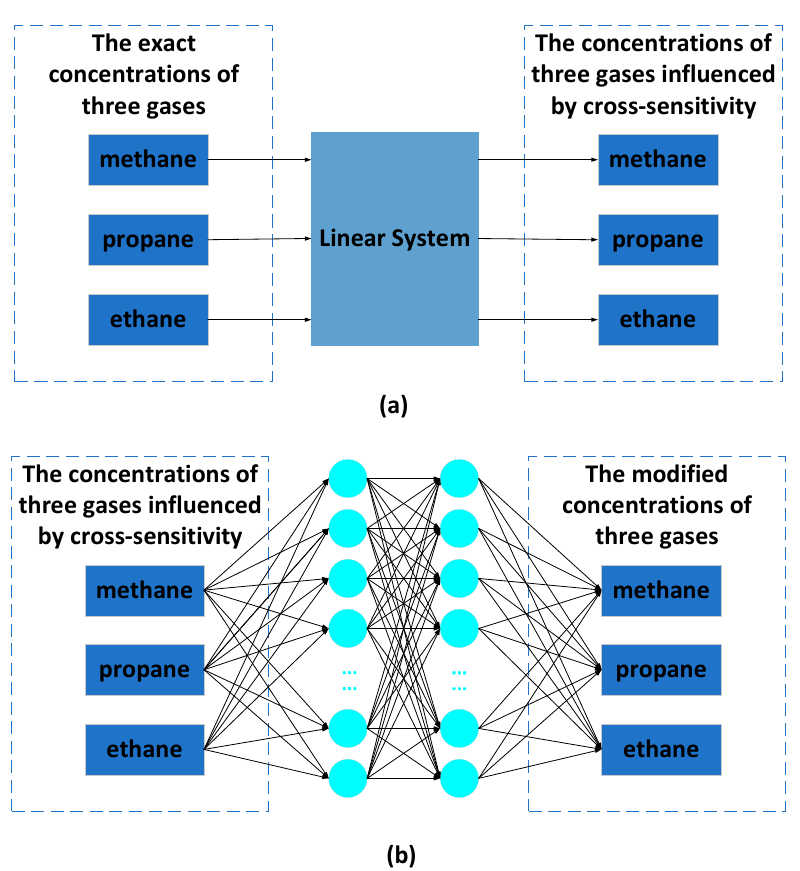
Figure 2. Two types of mixed gases recognition systems: ( a ) is a linear system, in which the outputs of the concentrations of the three gases are influenced by cross-sensitivity; ( b ) is a neural network (NN) recognition system, in which the outputs are close to the exact concentrations.